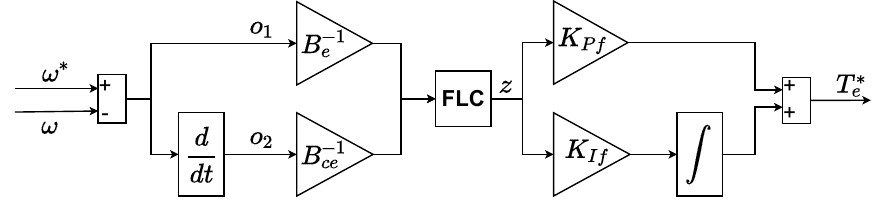
Figure 4. Topology of the fuzzy